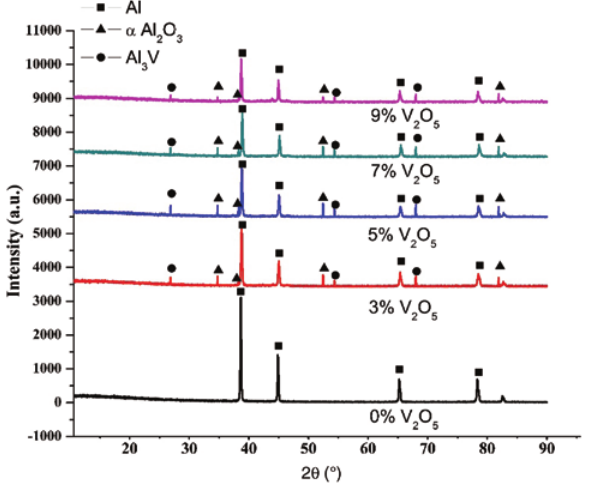
Figure 3: X-ray diffraction (XRD) pattern for cast in situ composite synthesized at 850 °